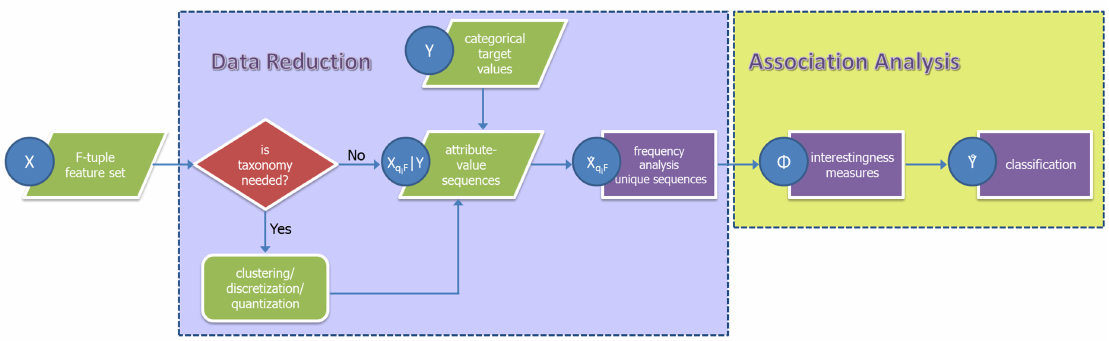
Figure 1. The general workflow of the symbolic machine learning (SML)